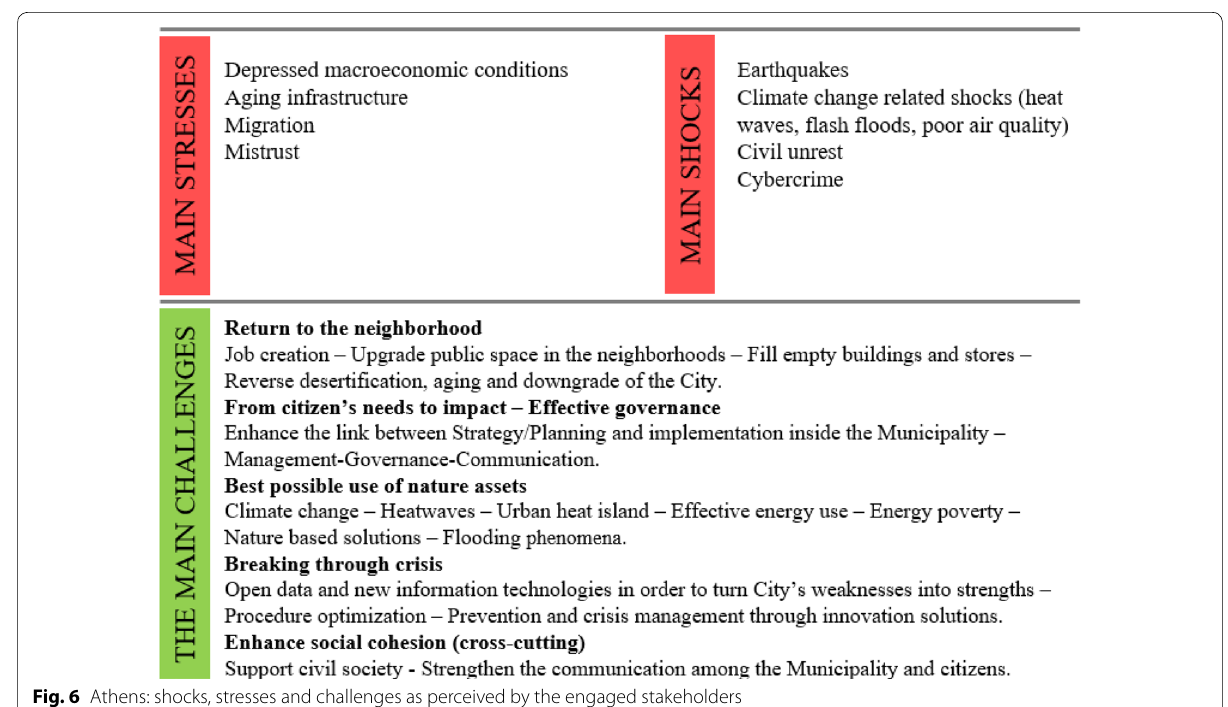
Fig. 6 Athens: shocks, stresses and challenges as perceived by the engaged